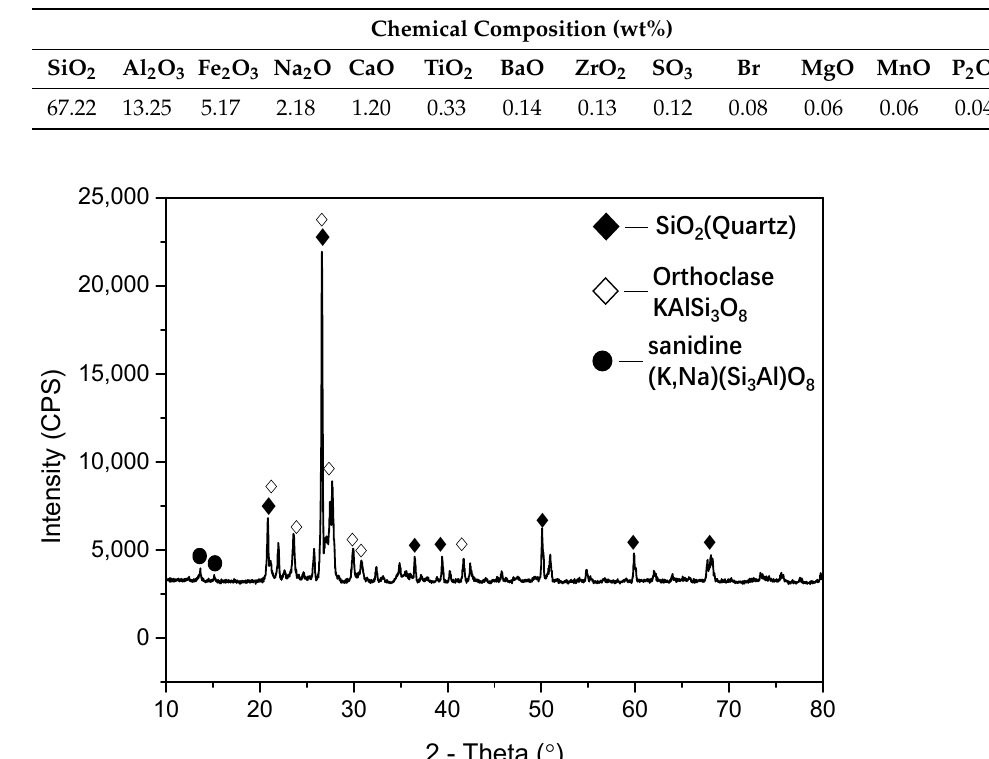
Figure 3. Molecular structure of the ether-based polycarboxylate (PCE) used in this study. Table 2. Characteristic molecular parameters of PCE-1. Sample Length of Side Chain (n EO ) Side Chain Den- sity (a:b)